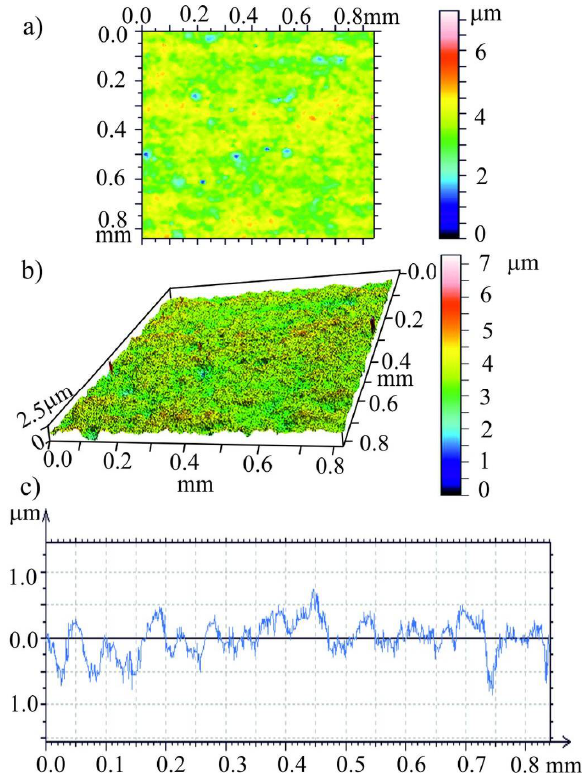
Fig. 4. Fragment of the plate’s smooth surface 0.45 mm thick: a) topography of a fragment of the melts, b) 3D topography, c) roughness profile.